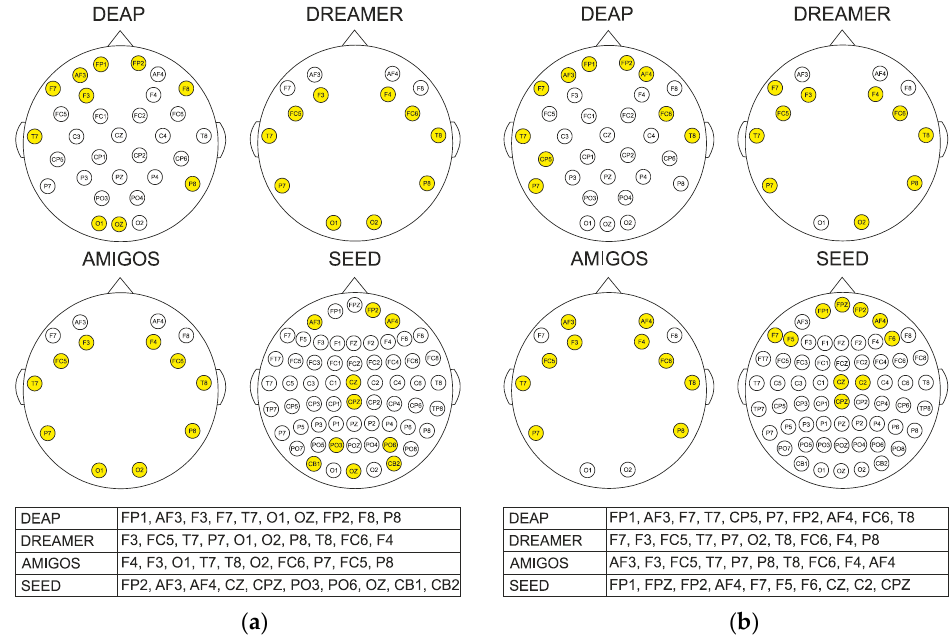
Figure 5. Head map with top 10 channels highlighted in yellow that are selected with ( a ) ReliefF and ( b ) NCA for each dataset.